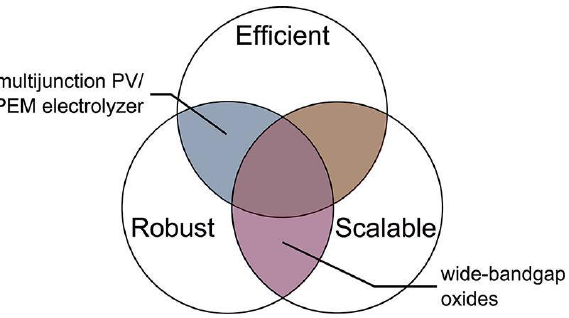
Figure 5. Venn diagram depicting the three requirements for an ideal solar water-splitting system [48]. Figure reused with permission from https://pubs.acs.org/doi/10.1021/cm4021518 (accessed on 5 September 2022); further permission related to this article should be directed to ACS.